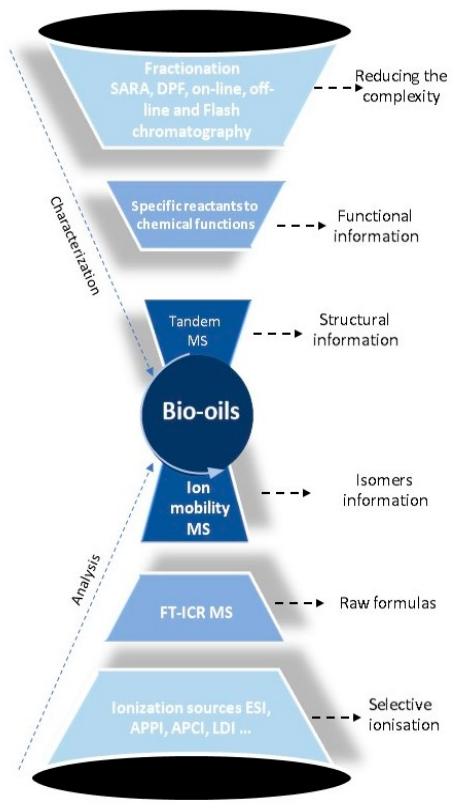
Figure 2. New methodologies in petroleomics that contribute to the chemical characterization of bio-oil at the molecular level.